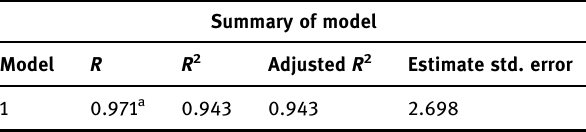
Table 6: Developed model summary Summary of model